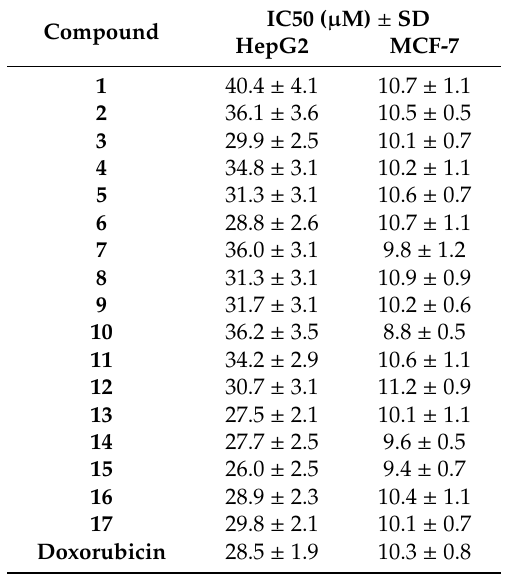
Table 1. The antiproliferative IC 50 values of the compounds 1 – 17 on the two human cell